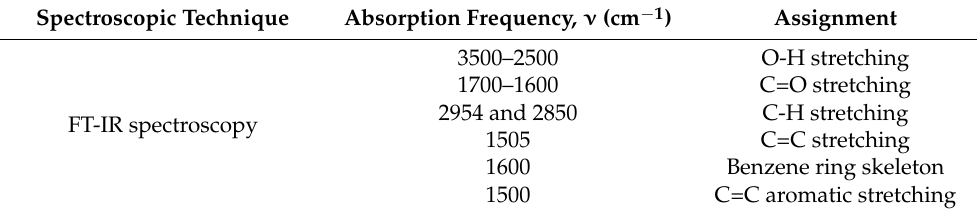
Figure 2. Standard normal variate (SNV) preprocessed FT − IR spectra ( a ). ( a1 , a2 ) are the extended spectral regions related to phenolic compounds. Table 1. FT-IR spectral vibrations of phenolic compounds observed in A. thaliana leaf powder samples.